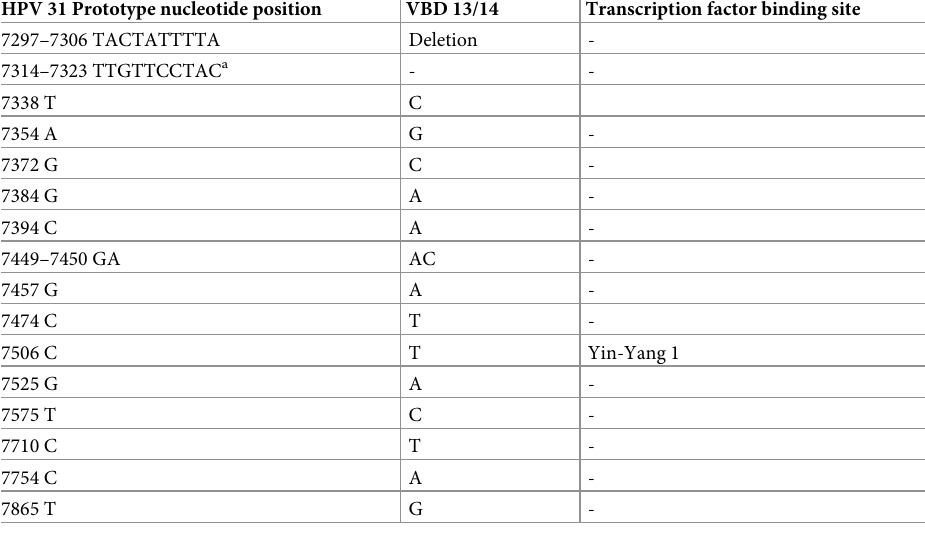
Table 2. Sequence differences in the noncoding LCR relative to the HPV31 prototype sequence (J04353.1). HPV 31 Prototype nucleotide